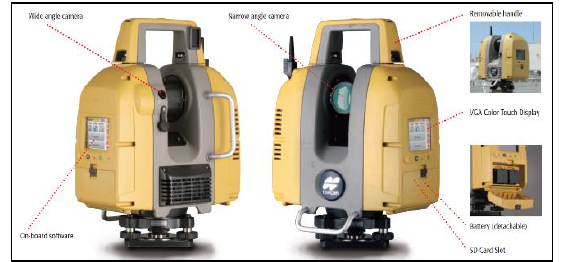
Figure 18. The Topcon GLS-2000